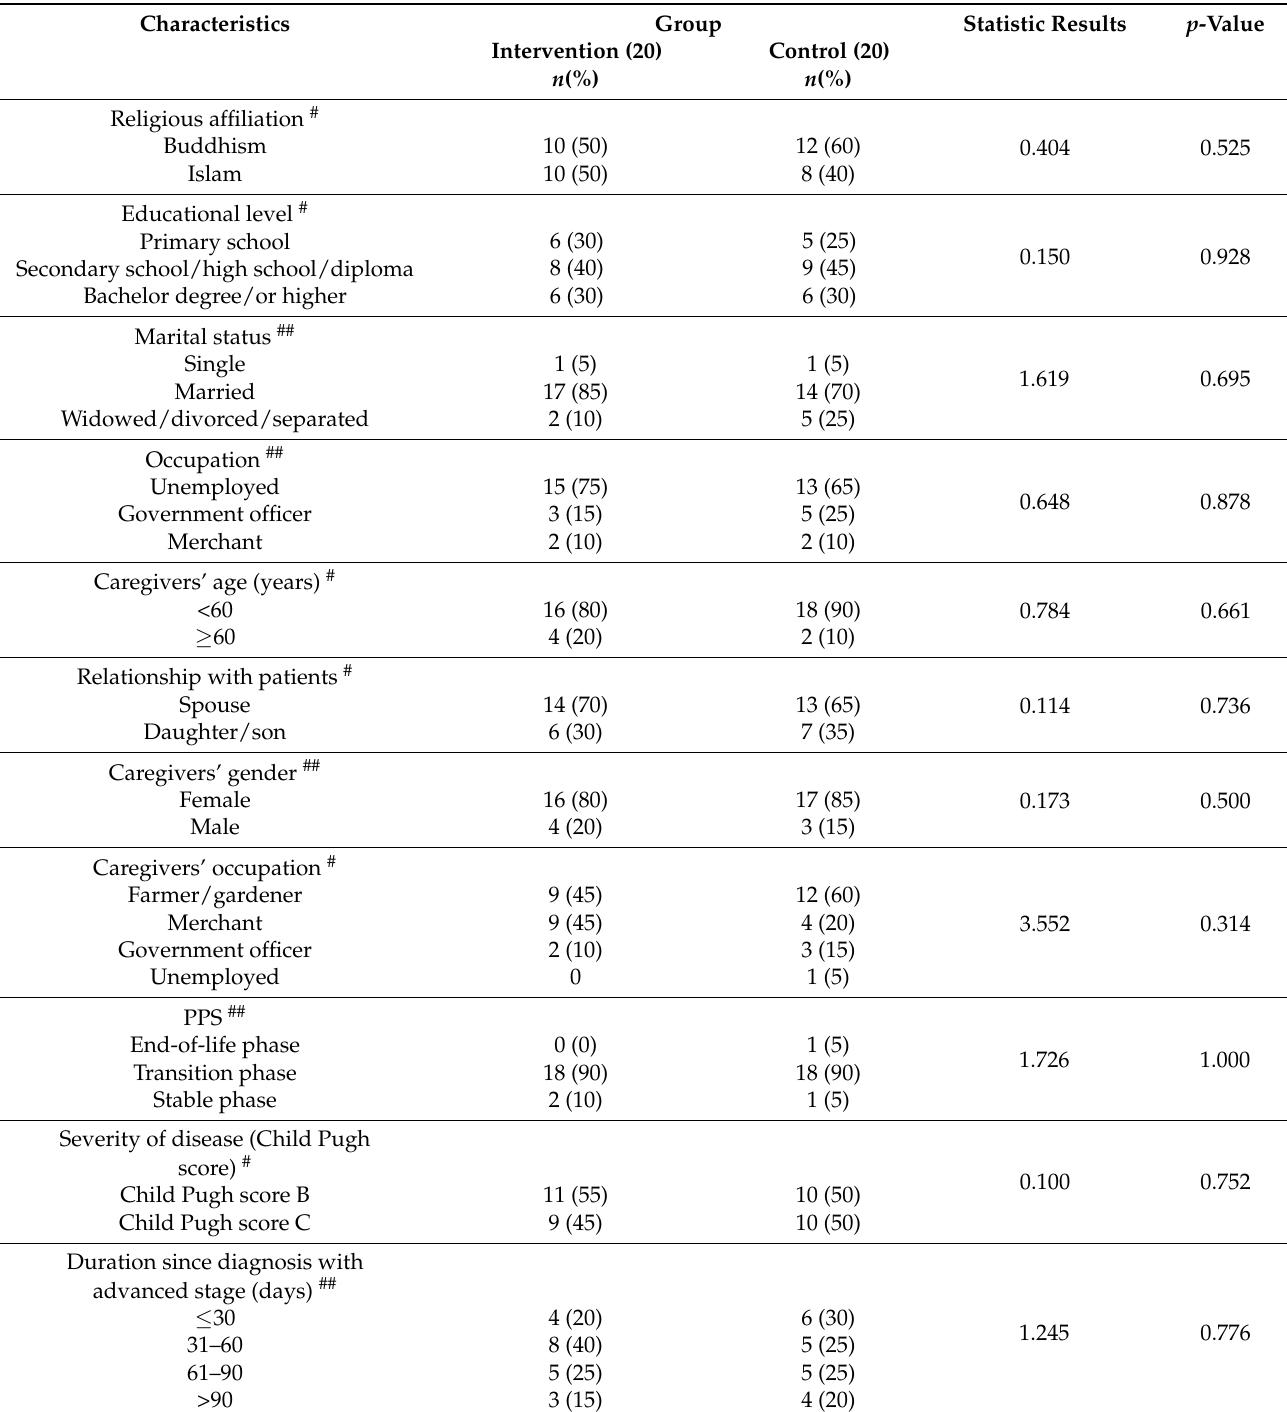
Table 2. Basic characteristics of patients with HCC in the experimental and control groups (N =